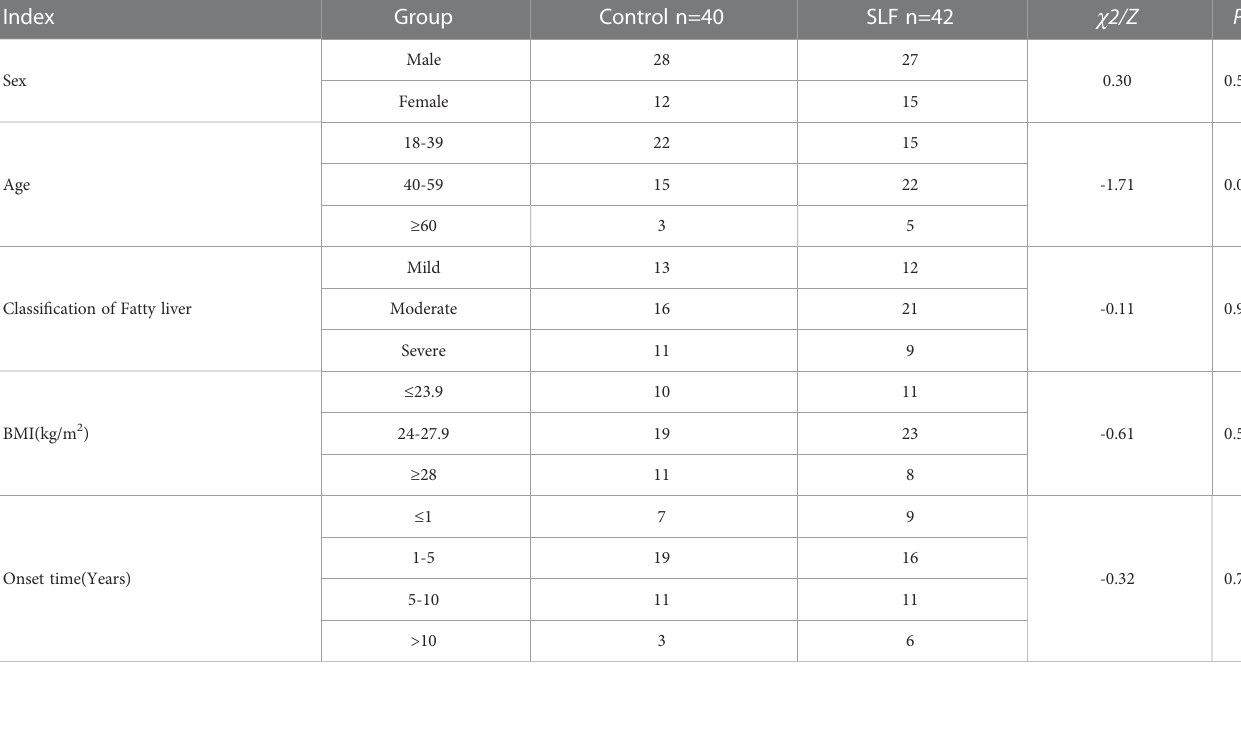
TABLE 1 Baseline of the NAFLD in the control group and SLF group.